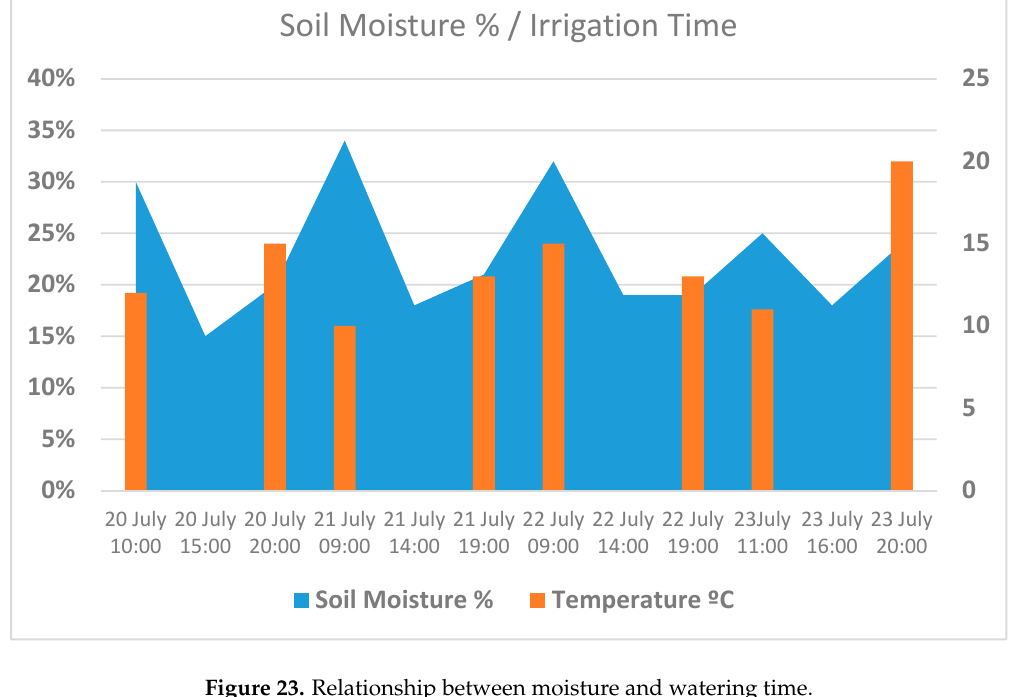
Figure 23. Relationship between moisture and watering time.